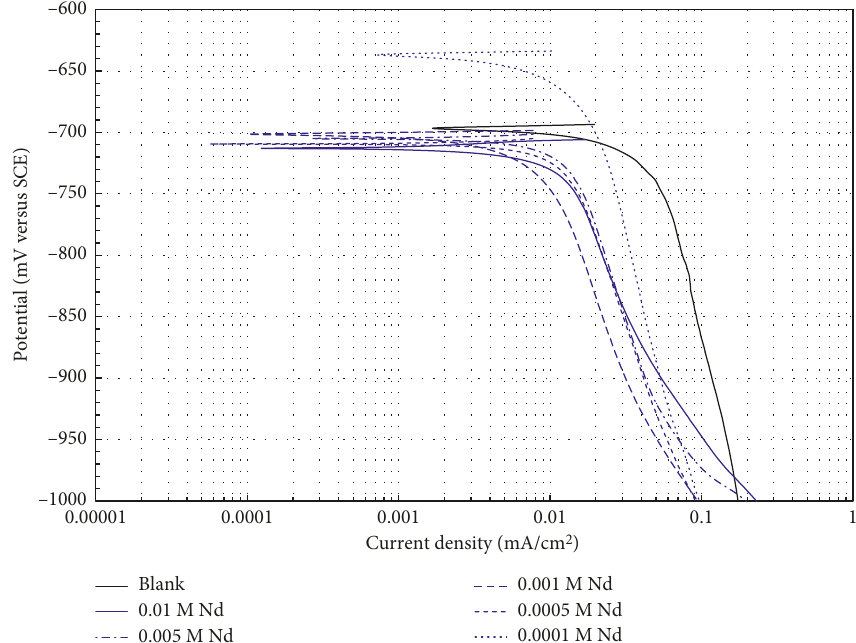
Figure 2: Cathodic polarization curves for API X70 steel in 3.5% NaCl solution at different concentrations of Nd 3+ ions (0.1667mV · s − 1